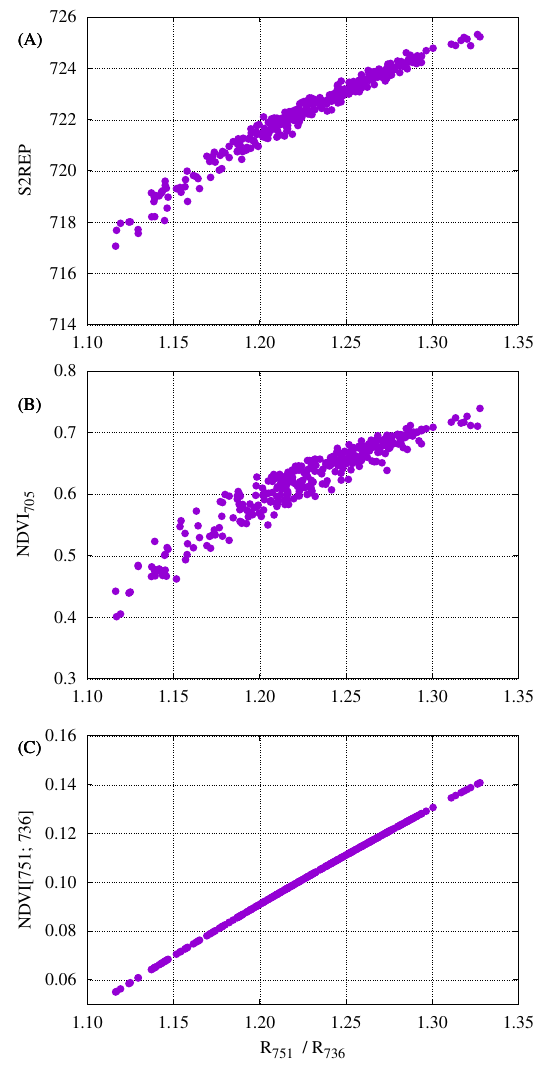
Figure 4. New simple ratio vegetation index R 751 /R 736 in relation to: ( A ) red edge inflection point estimate S2REP ( ρ = 0.99, p < 0.001); and ( B ) NDVI 705 ( ρ = 0.95, p < 0.001). ( C ) Relationship between the same vegetation index in SR and NDVI forms (using spectral bands at 736 nm and 751 nm) ρ = 1, p <